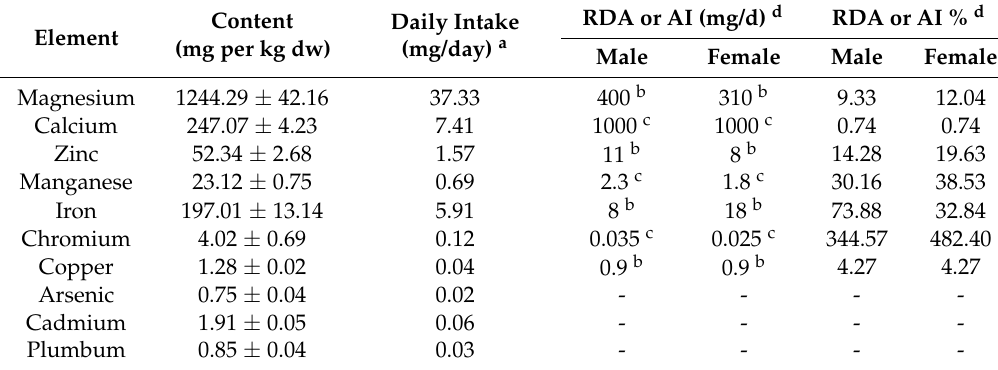
Table 2. Contents and daily intake estimations of metal elements of wild L. deliciosus